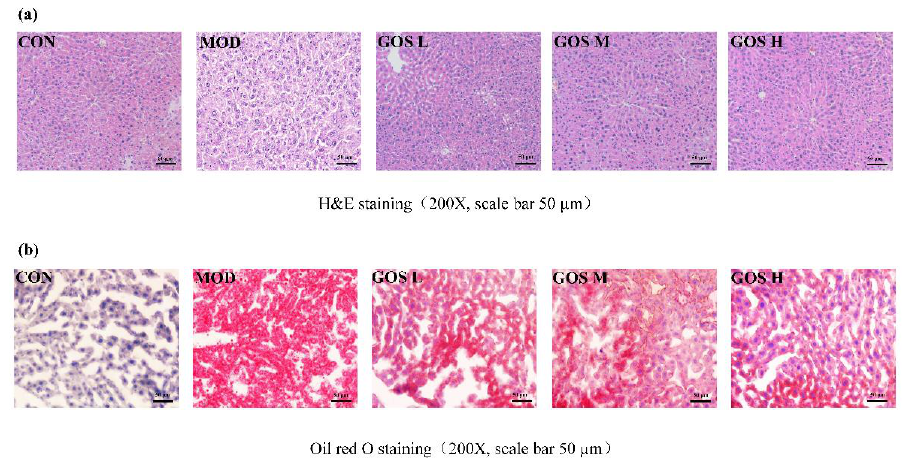
Figure 4. Histopathological observation of the liver. ( a ) Pathological image of liver tissue stained with haematoxylin and eosin (H&E) (200×, scale bar = 50 μm). ( b ) Pathological image of liver tissue stained with oil red O (200×, scale bar = 50 μm).